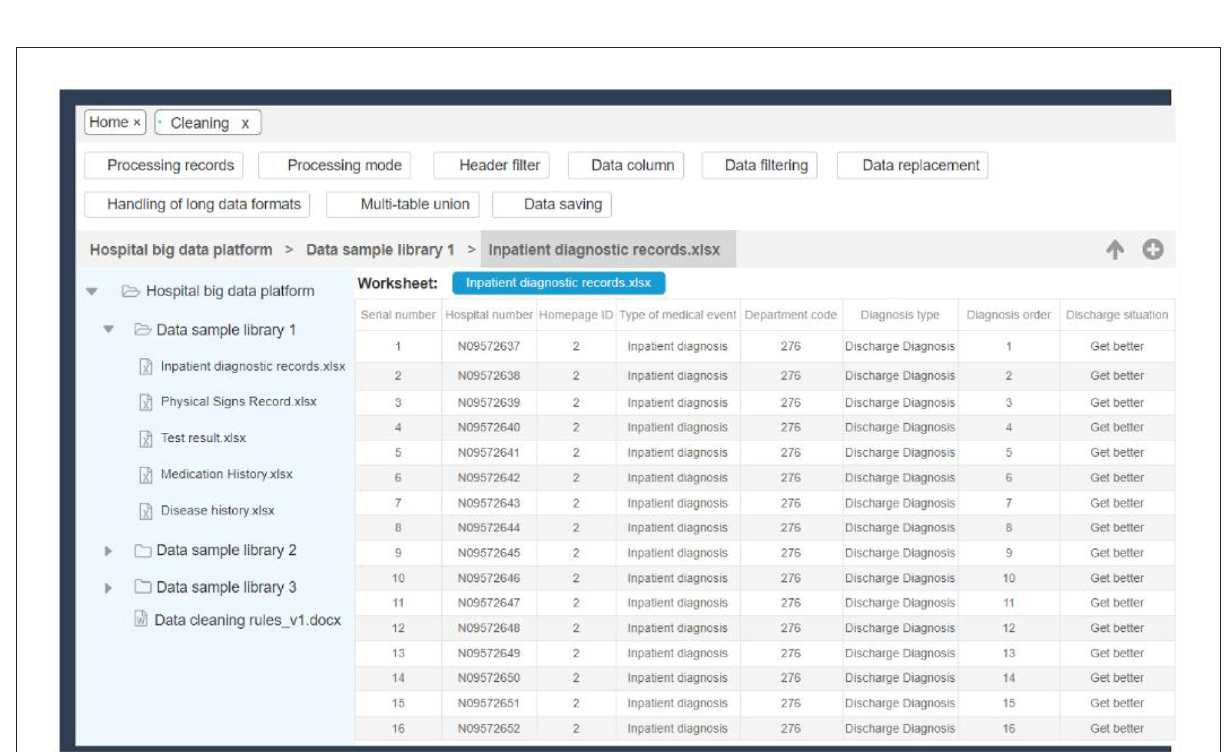
FIGURE6 Data governance